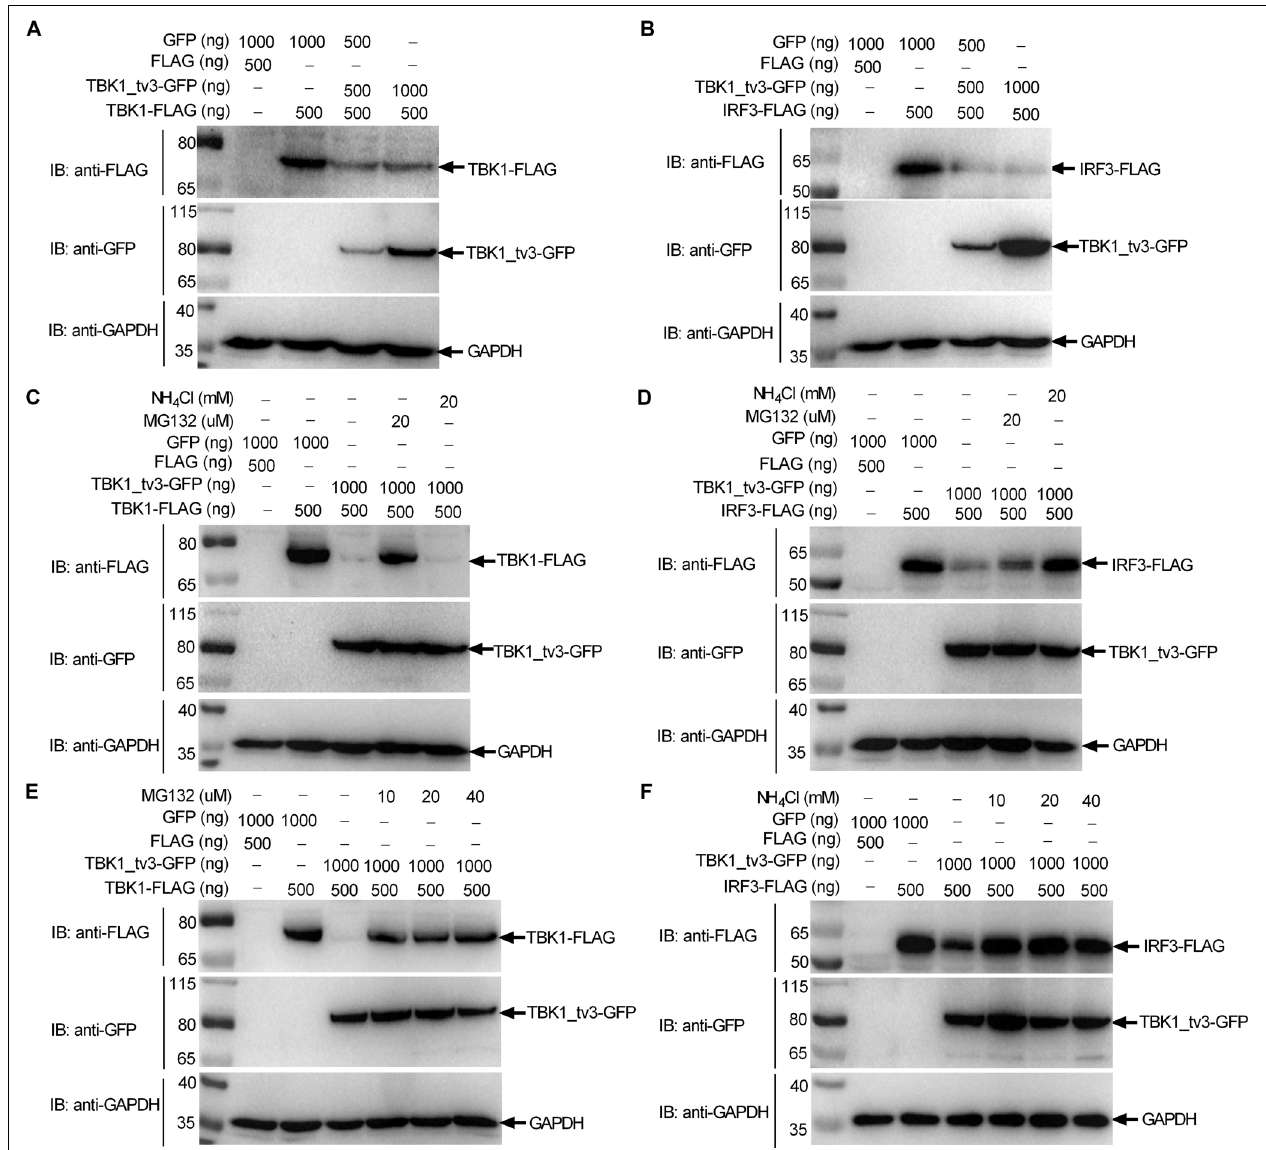
FIGURE 5 | TBK1_tv3 promotes proteasomal degradation of TBK1 and lysosomal degradation of IRF3. (A) The effect of TBK1_tv3 on the protein expression of TBK1. (B) The effect of TBK1_tv3 on the protein expression of IRF3. For A,B , EPC cells seeded in six-well plates were transfected with various indicated plasmids with indicated DNA concentration. After 48 h post-transfection, cell lysates were analyzed by immunoblotting using the indicated Abs. (C) TBK1_tv3 promotes the degradation of TBK1 by ubiquitination pathway. (D) TBK1_tv3 induced the degradation of IRF3 by lysosome pathway. (E) TBK1_tv3 promotes the degradation of TBK1 by ubiquitination pathway independent of the dose variation. (F) TBK1_tv3 induced the degradation of IRF3 by lysosome pathway independent of the dose variation. For C–F , EPC cells seeded in six-well plates were transfected with various indicated plasmids with indicated DNA concentration. After 48